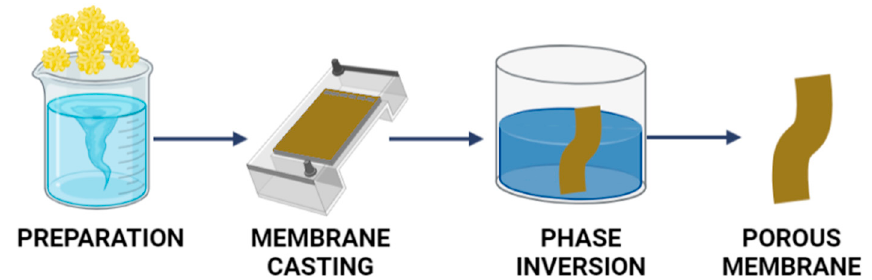
Figure 7. Formation of porous materials by phase